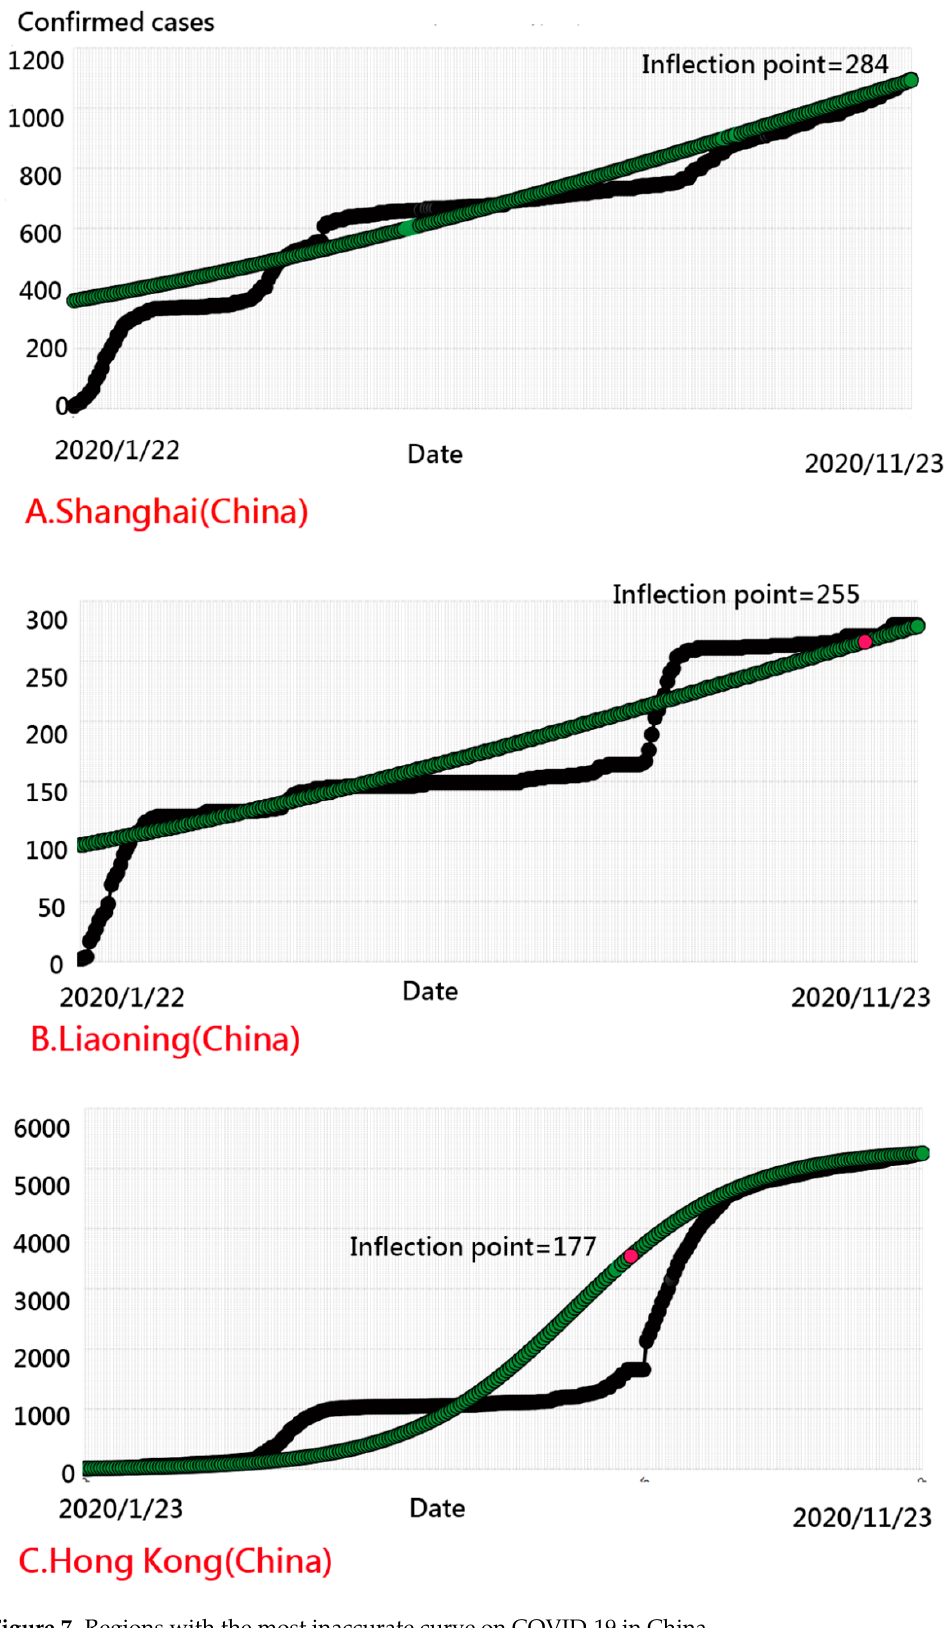
Figure 7. Regions with the most inaccurate curve on COVID-19 in China.